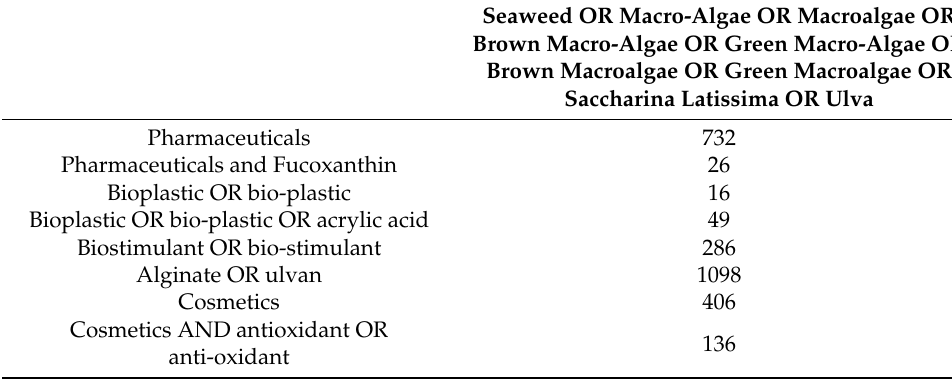
Table A1. Number of search results for each value